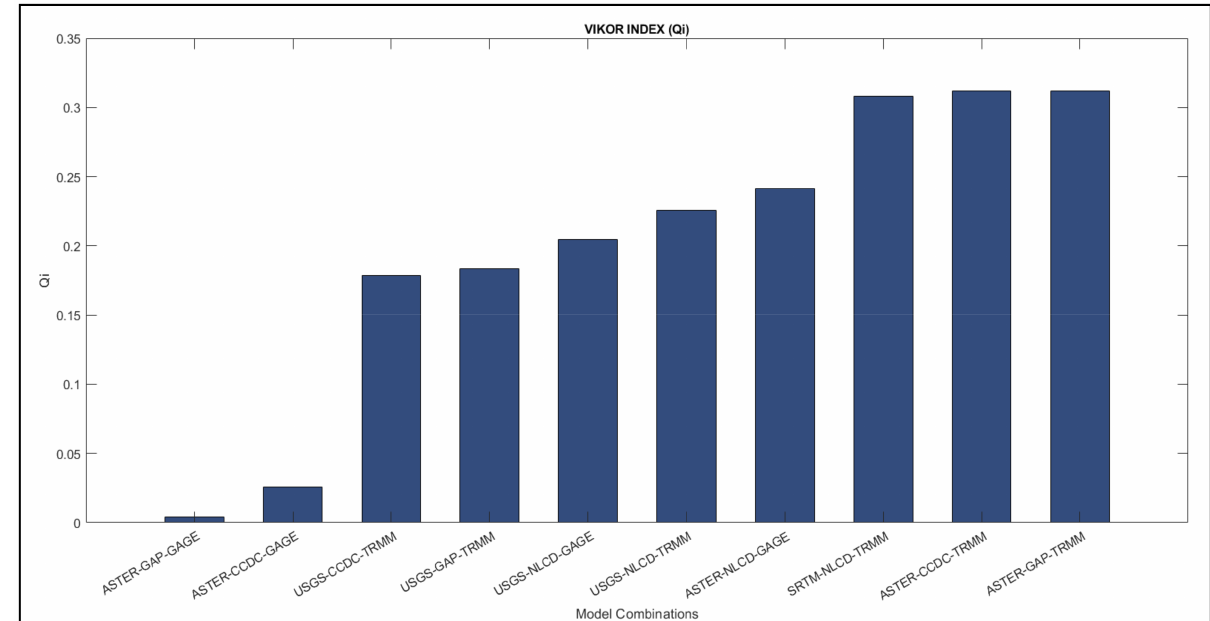
Figure 18. VIKOR index (Q i ) values were obtained for different model combinations. The model with minimum Q i value is considered as close to the optimal